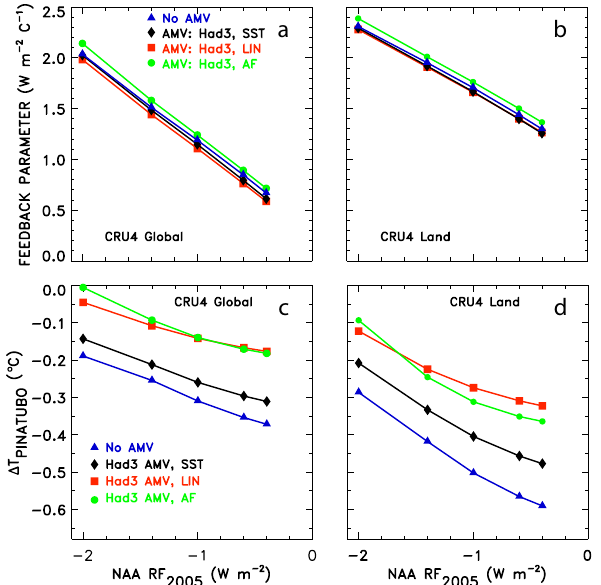
Fig. 11. (a) Climate feedback parameter ( λ in Eq. (2)) found for a regression of monthly mean global surface temperature anomaly from CRU4, as a function of NAA RF 2005 (using values of α COOL and α HEAT along the “Middle Road” of Fig. 4), for different treat- ments of the AMV index: none, AMV Had3 SST , AMV Had3 LIN and AMV Had3 AF . (b) Same as (a) except for a regression of the CRU4 monthly mean land surface temperature anomaly. (c) Maximum cooling due to the eruption of Mt. Pinatubo found by the regression of monthly mean global surface temperature anomaly from CRU4 as a function of NAA RF 2005 for different treatments of the AMV index. Here we show 1T PINATUBO as a negative numerical value to be consistent with the depiction 1T VOLCANO in other figures. We provide positive values of 1T PINATUBO in the context of “cooling”, in the text, to avoid the use of a myriad of minus signs. (d) Same as (c) except for a regression of CRU4 monthly mean land surface temperature